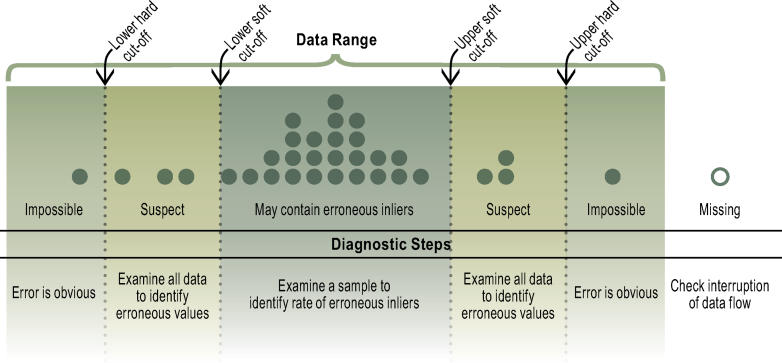
Areas within the Range of a Continuous Variable Defined by Hard and Soft Cutoffs for Error Screening and Diagnosis, with Recommended Diagnostic Steps for Data Points Falling in Each Area(Illustration: Giovanni Maki)